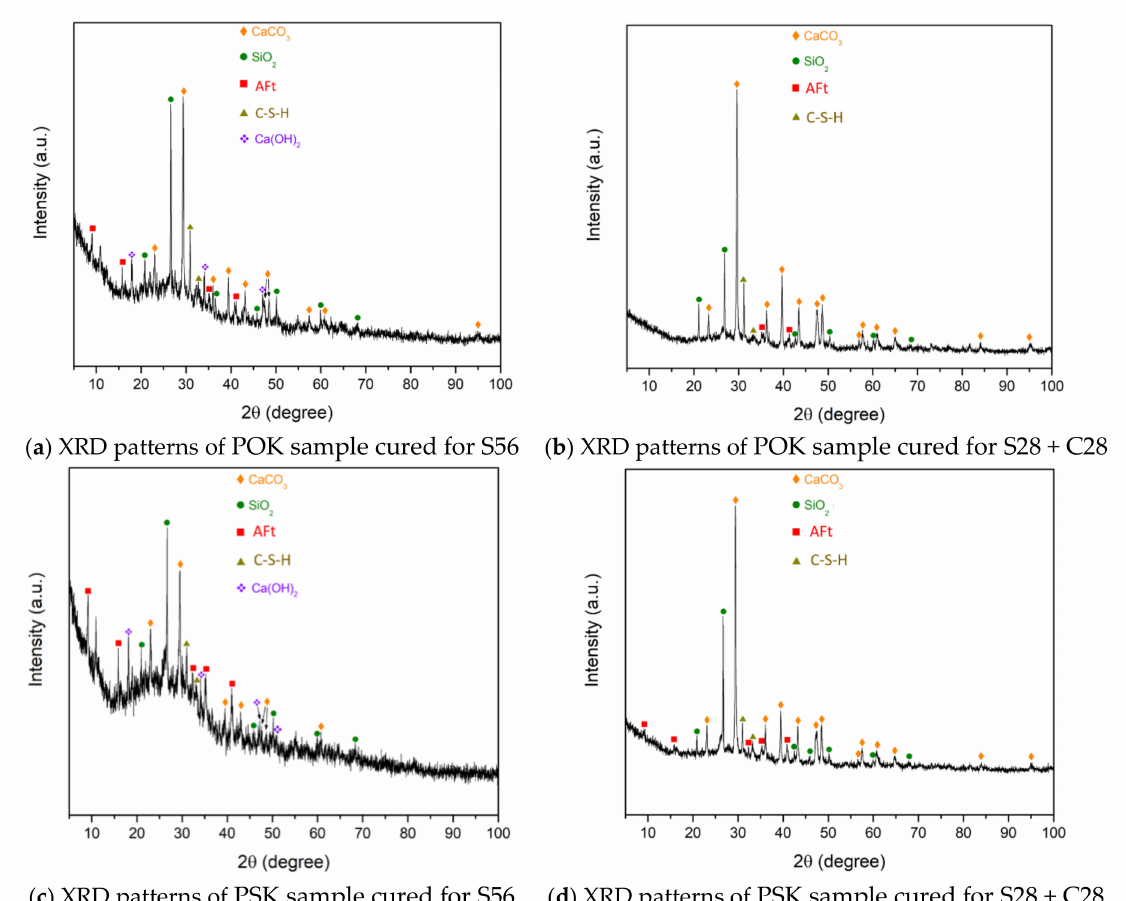
Figure 8. XRD patterns of